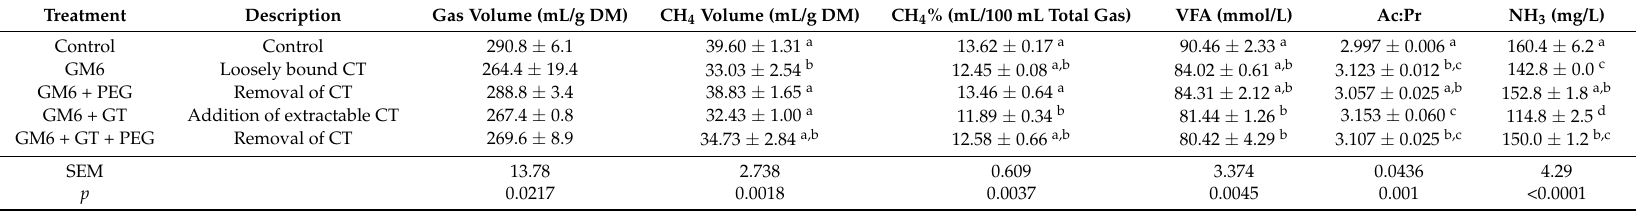
Table 2. In vitro fermentation parameters for Experiment 1; grape marc samples of differing tannin extractability. Treatment